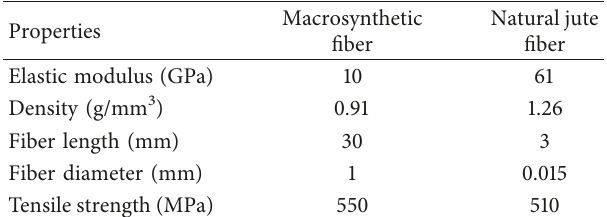
Table 5: Properties of